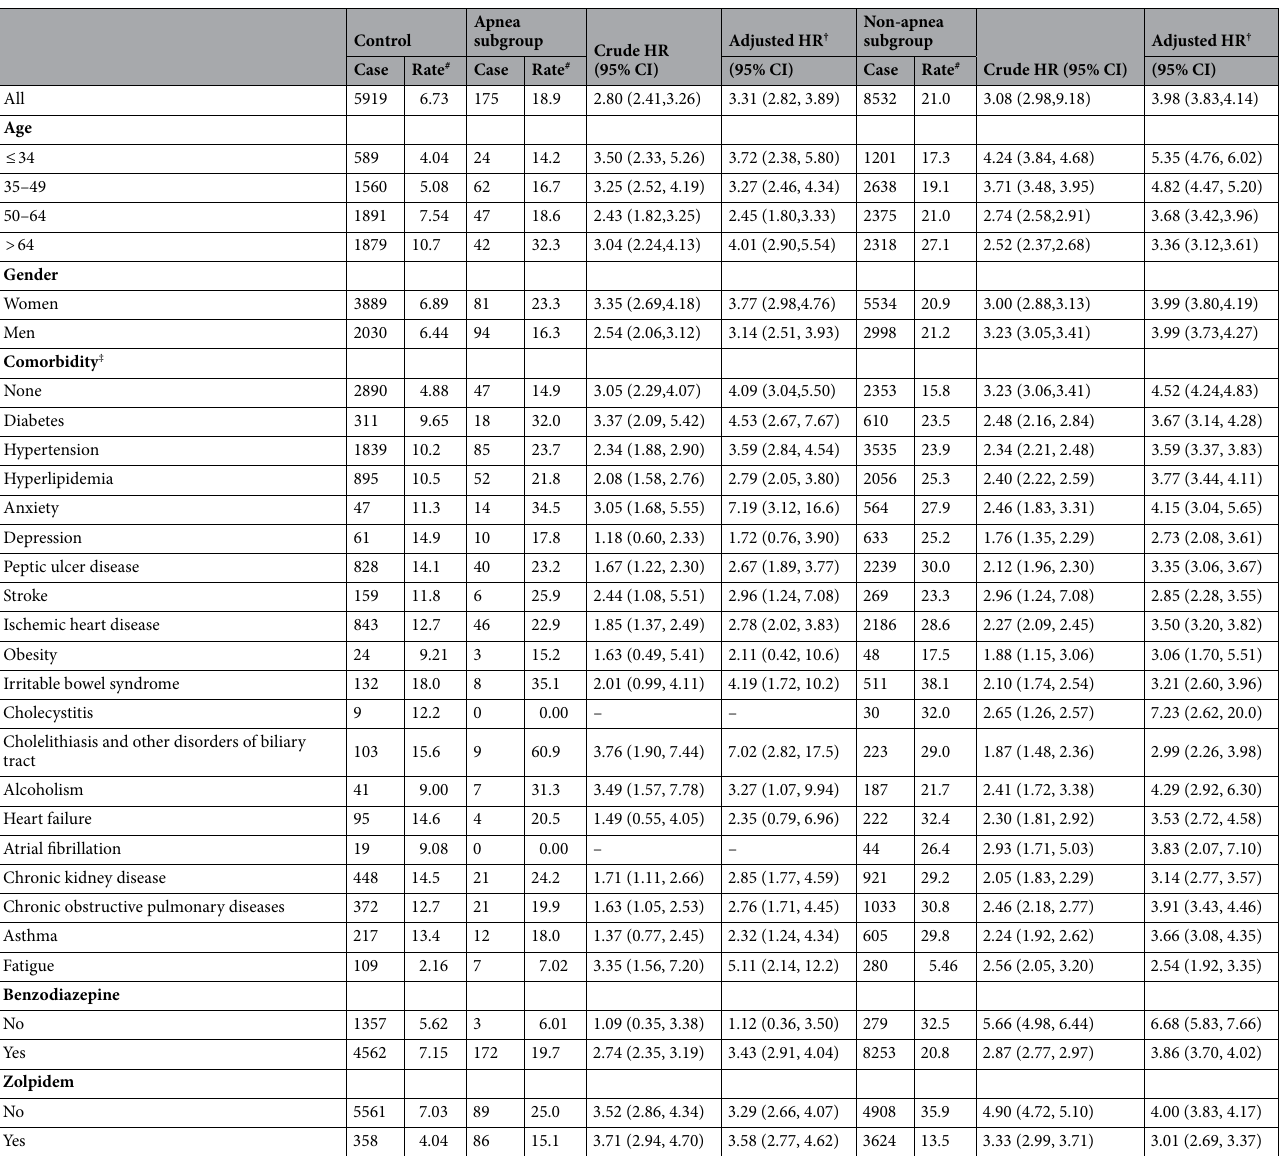
Table 2. Comparisons of incidence densities and hazard ratios of dyspepsia in exposed and control cohorts. Rate # , incidence rate, per 1,000 person-years; Crude HR*, relative hazard ratio, per 10,000 person-years; Adjusted HR † :models including age, sex, comorbidities, and medications. For all significance: p < 0.001.